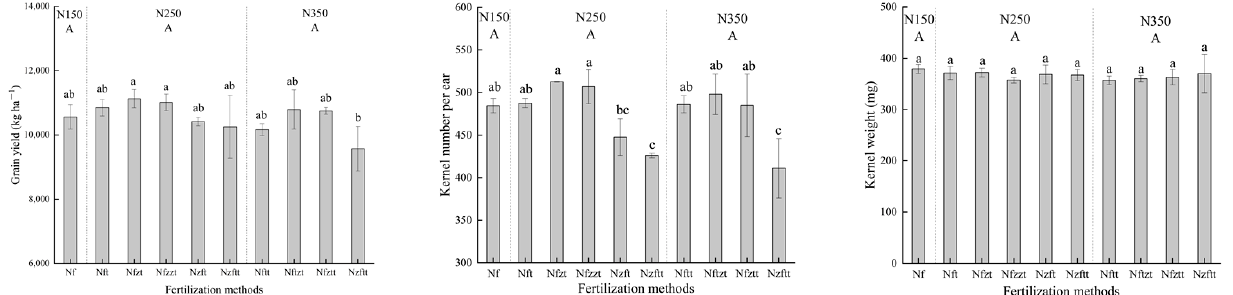
Figure 7. Effects of fertilization methods on maize yield, kernel number per ear, and kernel weight under different nitrogen application rates. N150, N250, and N350 refer to the nitrogen application rate being 150, 250, and 350 kg ha − 1 , respectively. “z” refers to the nitrogen application rate being zero, “f” refers to the nitrogen application rate being 150 kg ha − 1 , “t” refers to the nitrogen application rate being 100 kg ha − 1 , e.g., Nf refers to nitrogen application rate being 150 kg ha − 1 at sowing stage; Nfzt refers to nitrogen application rate being 150, 0, and 100 kg ha − 1 at sowing, 6-leaf, and 12-leaf stages, respectively; Nzftt refers to the nitrogen application rate being 0, 150, 100, and 100 kg ha − 1 at sowing, 6-leaf, 12-leaf, and silking stages, respectively. The data were averaged over 2018 and 2019. Capital letters indicate a significant difference at the p < 0.05 level under different nitrogen application rates. Lowercase letters indicate a significant difference at the p < 0.05 under all treat- ments.